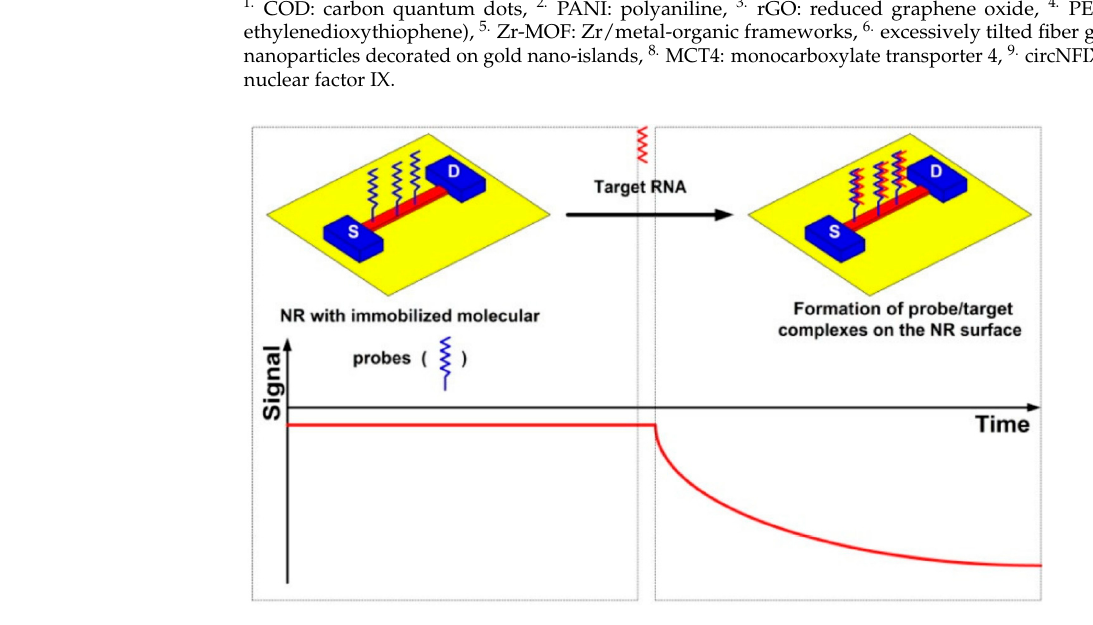
Figure 6. A schematic of the principle of the real-time nanoribbon (NR)-based RNA detection [101], reprinted with permission from MDPI. Table 1. Summary of developed biosensors for childhood cancers.